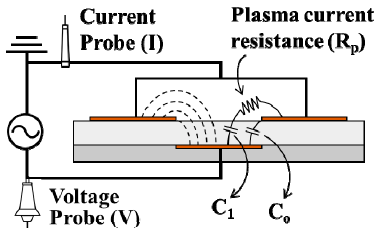
Figure 7. The equivalent circuit of the current–voltage measurement.